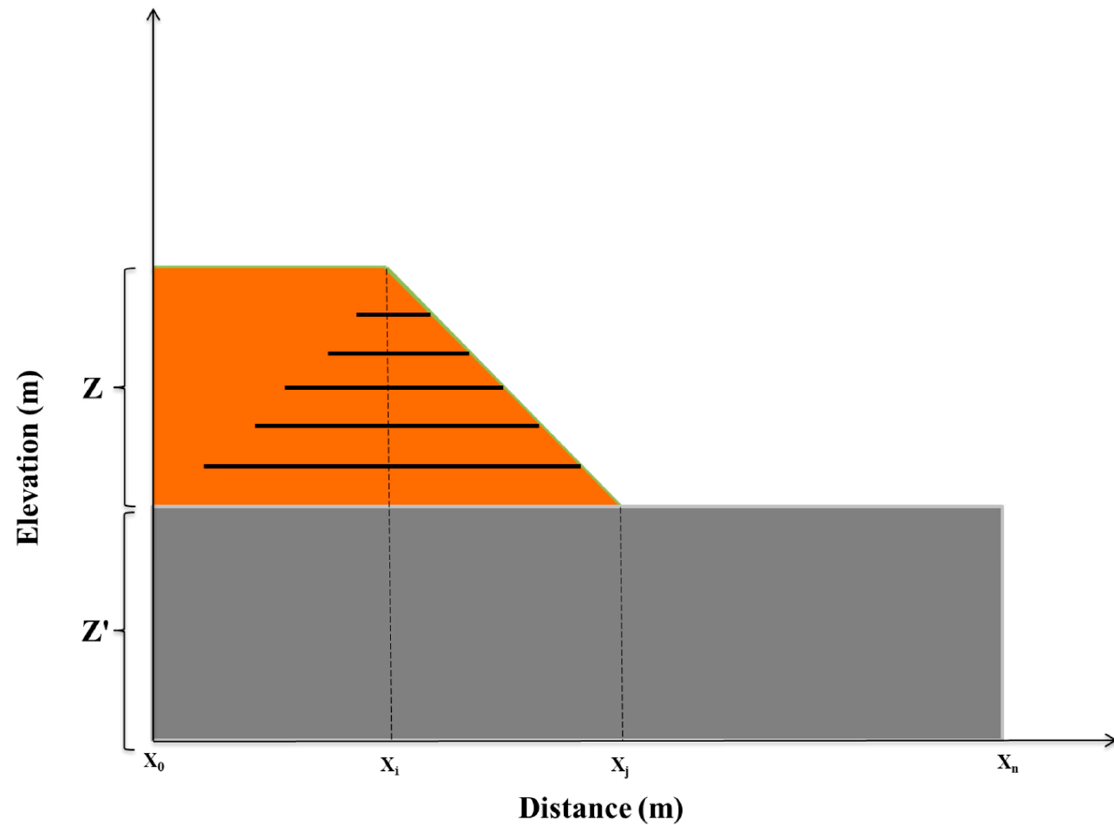
Figure 4. A reinforced slope sample in the study area.